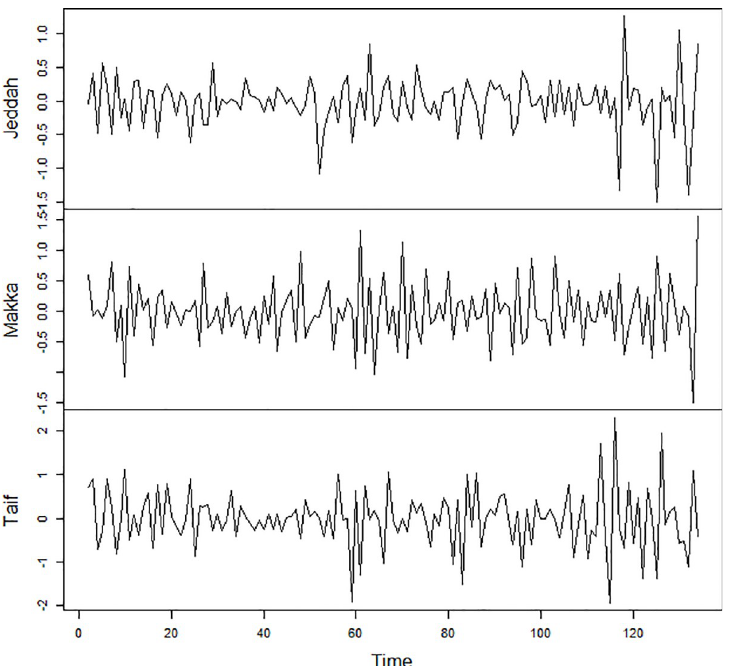
Fig 3. Time series plot of the differenced daily confirmed cases of